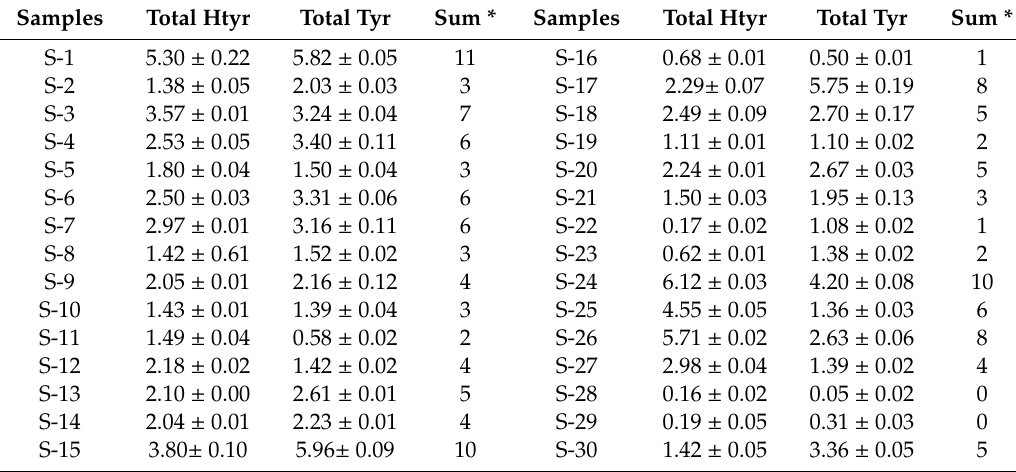
Table 2. Total (free and bound forms) Htyr and Tyr content (mg / 20 g oil) of VOO samples according to protocol